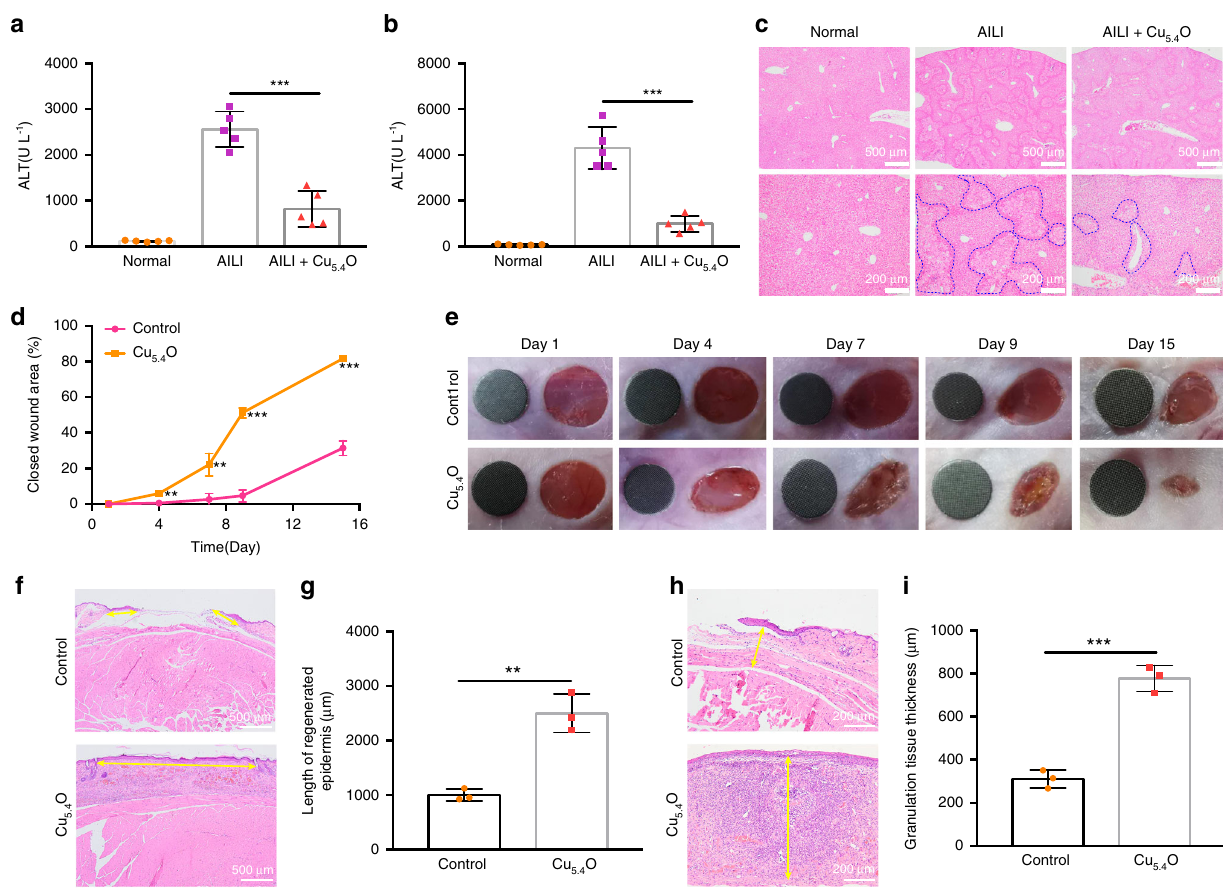
Fig. 8 Therapeutic ef fi ciency of Cu 5.4 O USNPs on AILI and wound healing. Serum levels of a AST and b ALT in AILI mice at 24 h after different treatment. c H&E staining of liver tissues from each group. Blue dashed lines indicate the range of hepatic necrosis. The percentage of d closed diabetic wound area and representative macroscopic appearance of e diabetic wound at different time points. A 6-mm-diameter standard green disc was used as the reference when taking photos. f Representative histological images and g quantitative determination of the length of regenerated epidermis on day 15 post-surgery. The yellow double-headed arrows indicate the regenerated epidermis. h Representative histological images and i quantitative measurement of granulation tissue thickness on day 15 post-surgery. The yellow double-headed arrows indicate the granulation tissue. In a , b , data represent means ± s.d. from fi ve independent replicates (one-way ANOVA). In d , g and i , data represent means ± s.d. from three independent replicates (Student ’ s t -test, ** P < 0.01; *** P < 0.001). Source data are provided as a Source Data fi